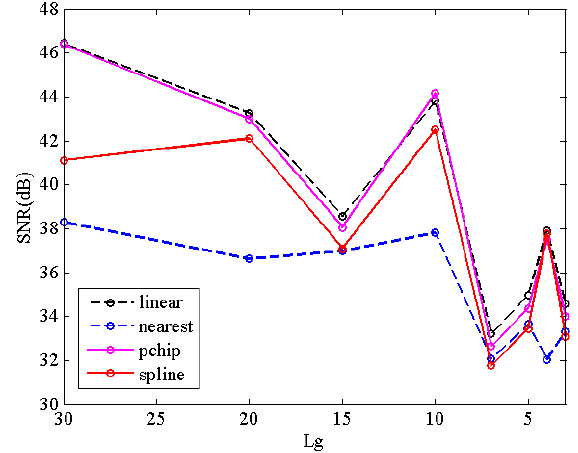
Figure 2. The performance of different interpolation methods.